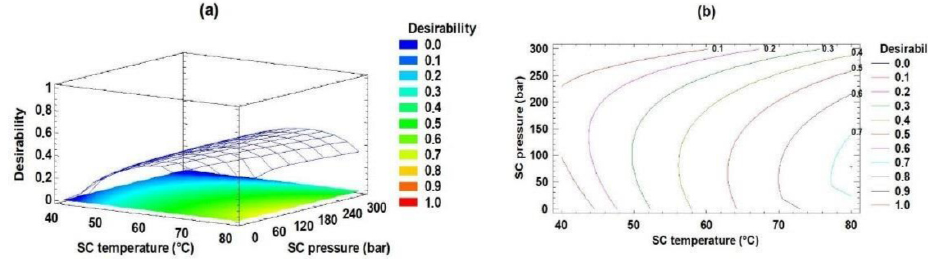
Figure 2. Effect of CO 2 SC temperature and CO 2 SC pressure on the sPAG synthesis. Panels ( a ) de- sirability function; ( b ) contours of estimated response surface.